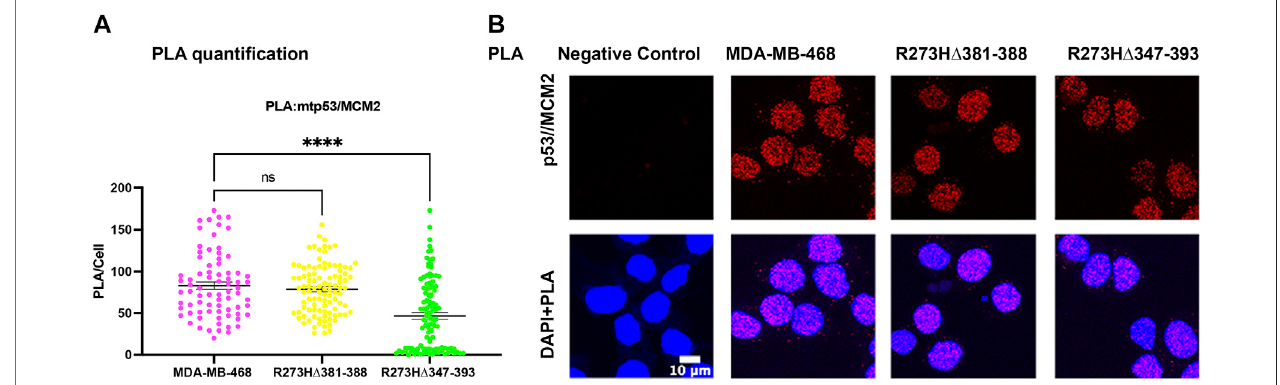
FIGURE 5 | Endogenous deletions in the OD of R273H mtp53 decreases the interaction between mtp53 and MCM2. (A) Analysis of p53/MCM2 complexes by in situ proximity ligation assay (PLA) in MDA-MB-468, R273H Δ 381-388 and R273H Δ 347-393 cells. Fluorescent foci per cell were counted by Cellpro fi ler software and depicted by a scatter plot using GraphPad Prism 9. The data represent a scatter plot with n (cid:2) 3. An ordinary one-way ANOVA was used to determine the statistical signi fi canceofthedata.Thefollowingformatwasusedtoassignsigni fi cancebasedon p -value:****representsa p -value ≤ 0.0001andnsrepresentnon-signi fi cant. (B) Representative confocal microscope images of p53/MCM2 foci/complexes (red) by in situ proximity ligation assay (PLA) in MDA-MB-468, R273H Δ 381-388 and R273H Δ 347-393 cells. DNA was counterstained with DAPI (blue). The z-stack maximum intensity projection images are shown. Three independent experiments were performed. (Scale bar (cid:2) 10